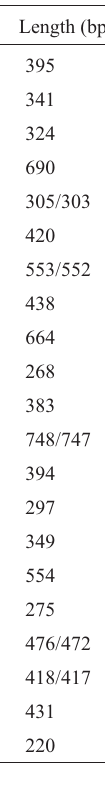
Table 1 - Information for PCR amplification of the genes genotyped on the IMpRH